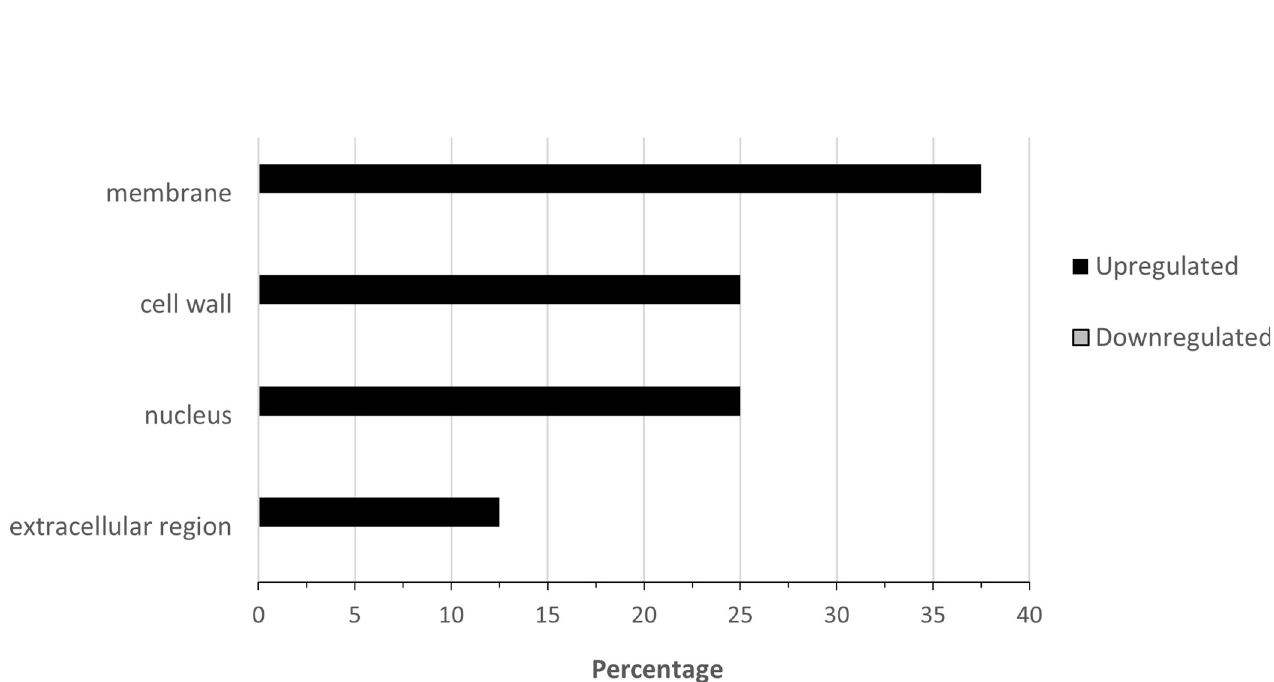
Fig 11. Percentage of upregulated (n = 8) and downregulated (n = 0) transcripts from the Top 50 differentially expressed genes (DEGs) when nickel resistant Populus Tremuloides genotypes were compared to nickel susceptible genotypes. Only transcripts with assigned gene ontology were included and these were grouped by cellular component using BLAST2GO (Omics Box).